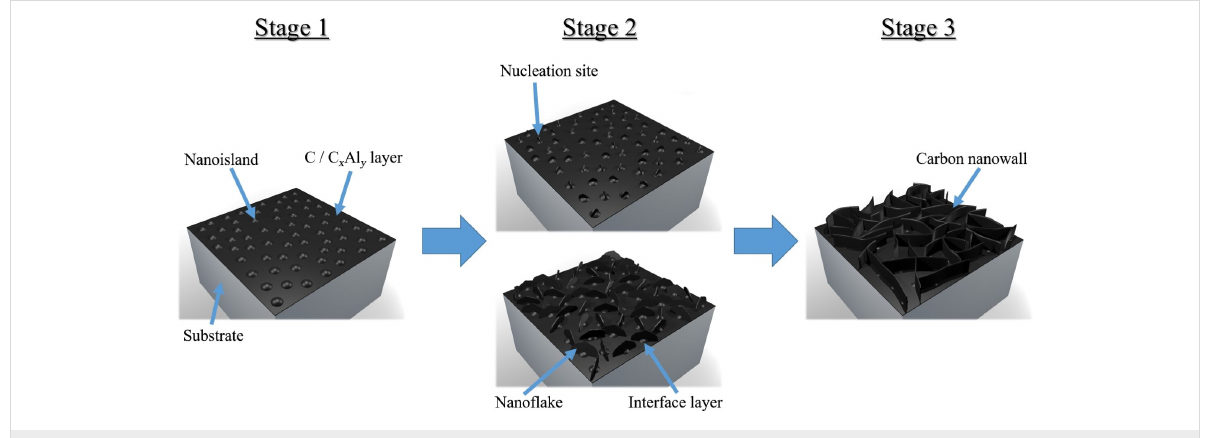
Figure 1: Three-stage model of CNW growth (adapted from Kondo and co-workers)